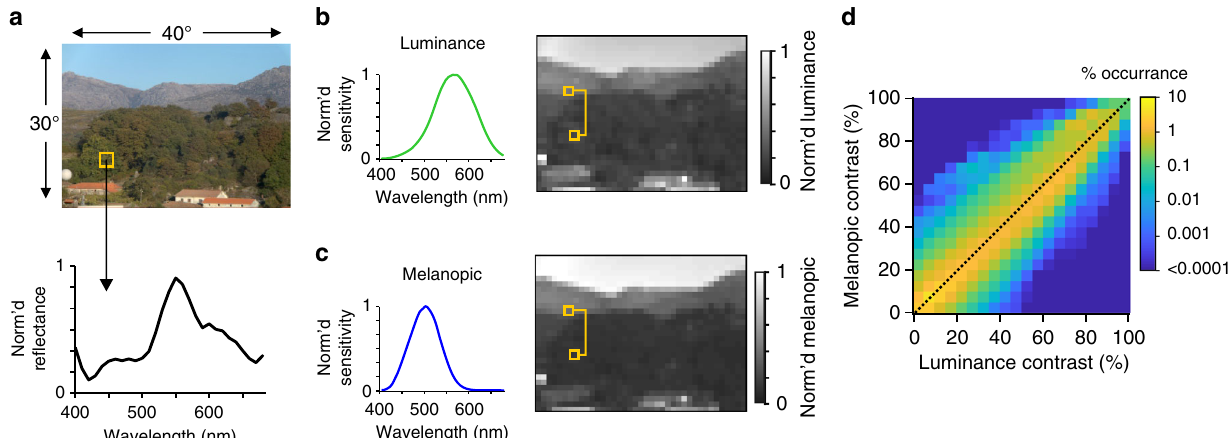
Fig. 4 Divergence in melanopsin vs. luminance contrast in natural scenes. a Upper panel shows representative RGB rendering of a hyperspectral scene 43 . Images were assumed to occupy 30° × 40° visual space. Lower panel shows spectral power distribution for a representative ‘ pixel ’ from this scene (occupying a 1.5° square of visual space to approximate spatial resolution of melanopic vision). b Depiction of image in ( a ) spatially down sampled to produce ‘ pixels ’ at 1.5° square and with greyscale level used to depict luminance (scale bar to right, 0 and 1 = lowest and highest luminance pixel) calculated by applying the luminance sensitivity function 42 (shown to left) to spectral power distribution for each pixel. Yellow boxes indicate a representative pixel pair across which luminance contrast can be calculated. c As for ( b ), but depicting melanopic radiance calculated using melanopic sensitivity function (to left). d 2D histogram showing distribution of luminance and melanopic radiance contrast for all pixel pairs (as a % of total pixel pairs per image; scale to right) from 13 hyperspectral images. Dotted line shows point of equal luminance and melanopic stimuli (Fig. 3b; 214 cd m − 2 ). The relationship between light